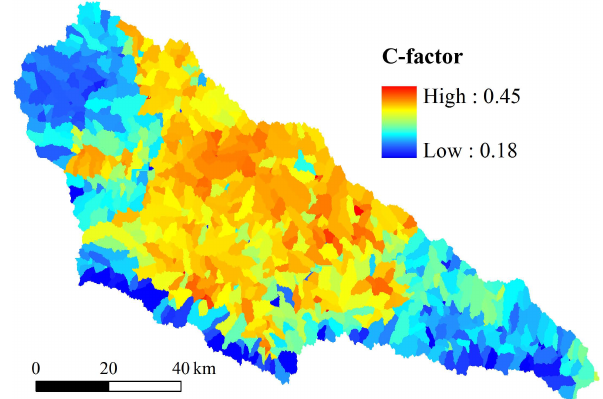
Fig. 7. Spatial distribution of the SL sw values in the Yanhe watershed.